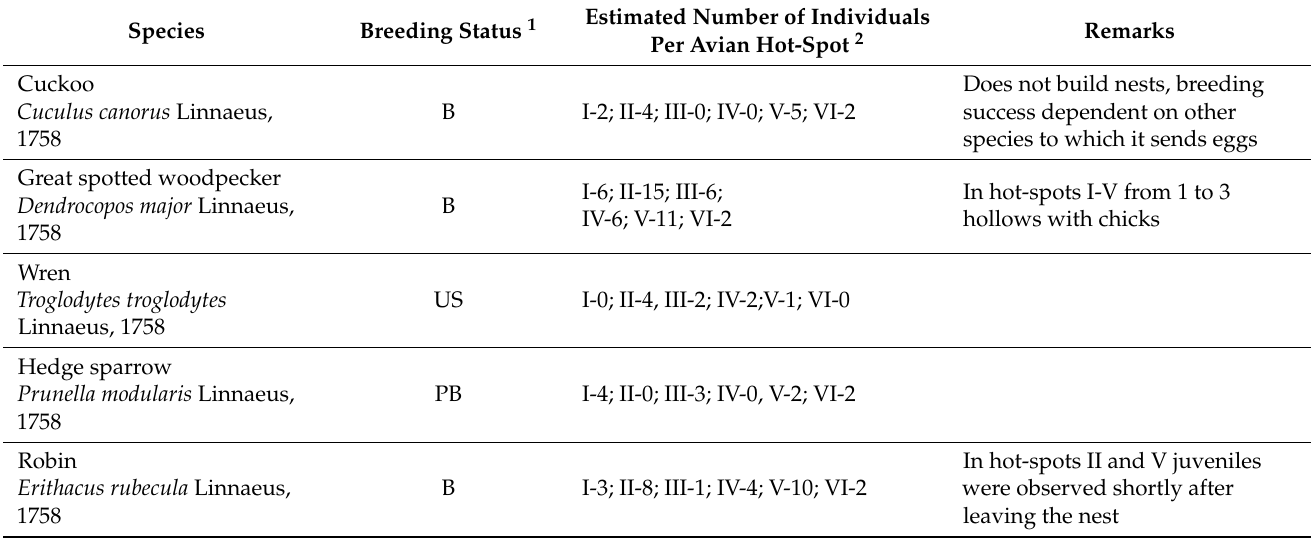
Figure 4. The locations of the five bird species considered particularly important for the biocenosis of Bielański Forest. Table 4. The results of the bird observations at the hot-spots.